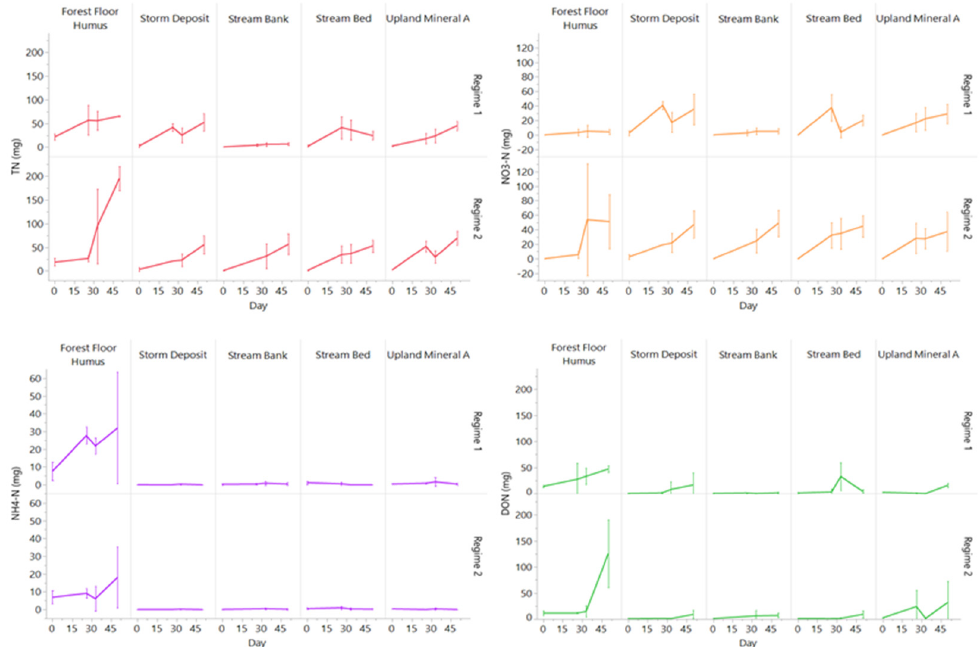
Figure 6. Temporal patterns of porewater ‐ dissolved N species–total dissolved N (red), nitrate ‐ N (orange), ammonium ‐ N (purple) and dissolved organic N (green) over the incubation period for the five sources and two moisture regimes. Regime 1: continuously moist and regime 2: dry ‐ wet cycle. The porewater DOC mass over the 50 ‐ day period decreased for all sources across both regimes except for the forest floor in regime 1 (Figure 7). The changes to the forest floor DOC for both moisture treatments dwarfed those of the other sources. Porewater DOC for forest floor humus in regime 1 increased through the incubation while the re ‐ verse was observed for regime 2. Net changes in porewater N and C per unit of the sediment mass of the sources indi ‐ cated important differences in source–sink behavior (Figure 8). Forest floor DOC was an important source of ammonium ‐ N and DON for both regimes and for nitrate ‐ N in regime 2. The difference in N response between the moisture regimes was especially pronounced for nitrate ‐ N. Nitrate ‐ N values for all sources (including the N ‐ poor sources, storm de ‐ posit, stream bank soil, and bed) during regime 2 were greater than their corresponding regime 1 values indicating an increased release of nitrate ‐ N. A contradictory response was observed for DOC with the forest floor being a significant source in regime 1 but a sink in regime 2.